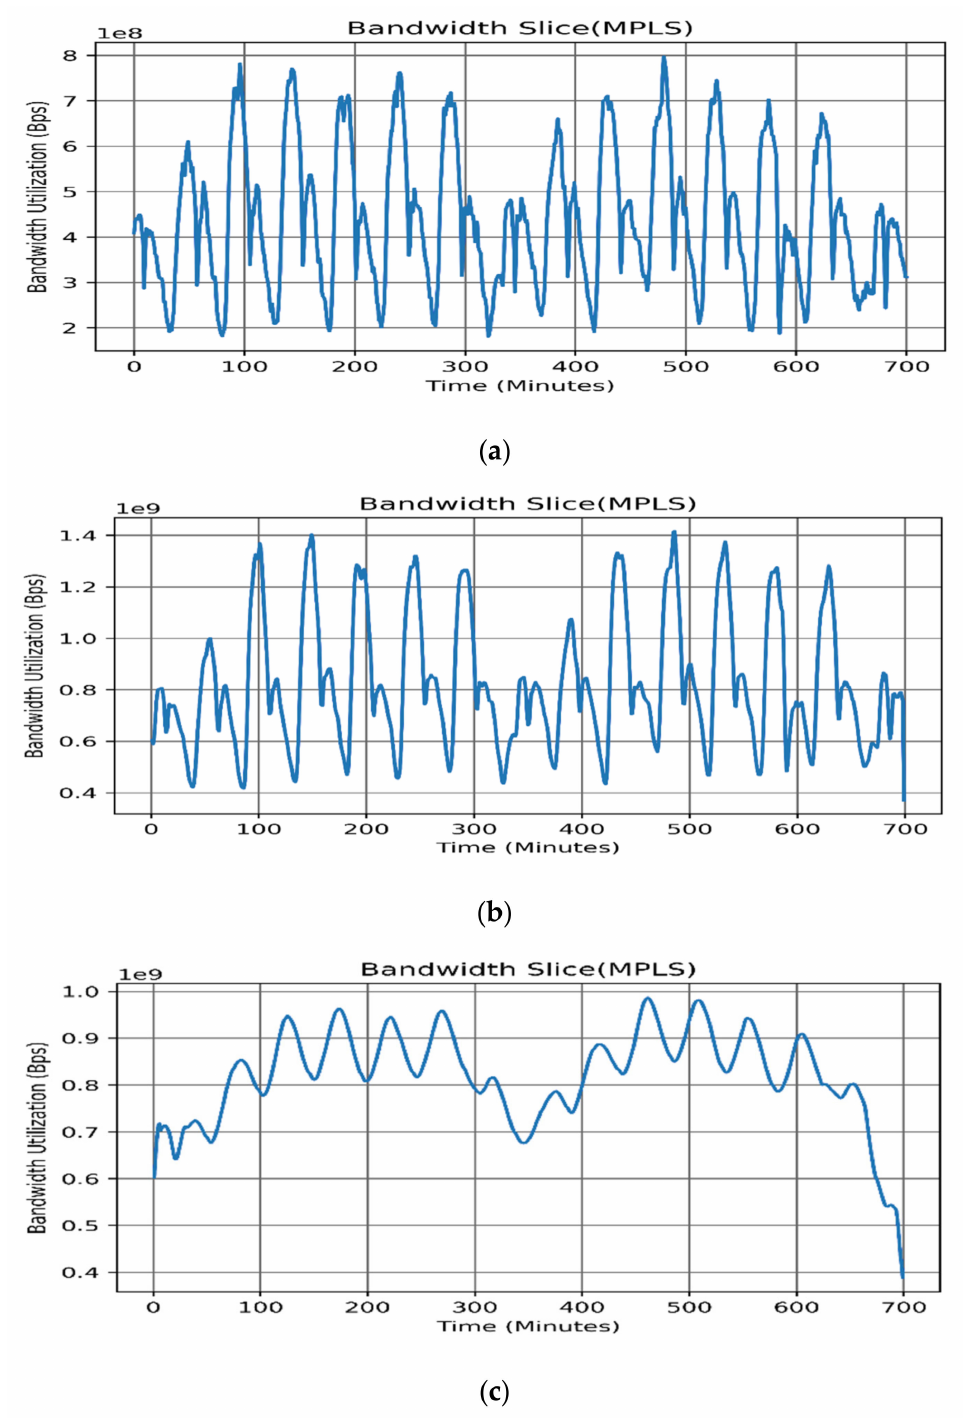
Figure 6. Bandwidth utilization using moving average: ( a ) original MPLS slice ( b ); MPLS slice smoothed with q = 0.003; and ( c ) MPLS slice smoothed with q =